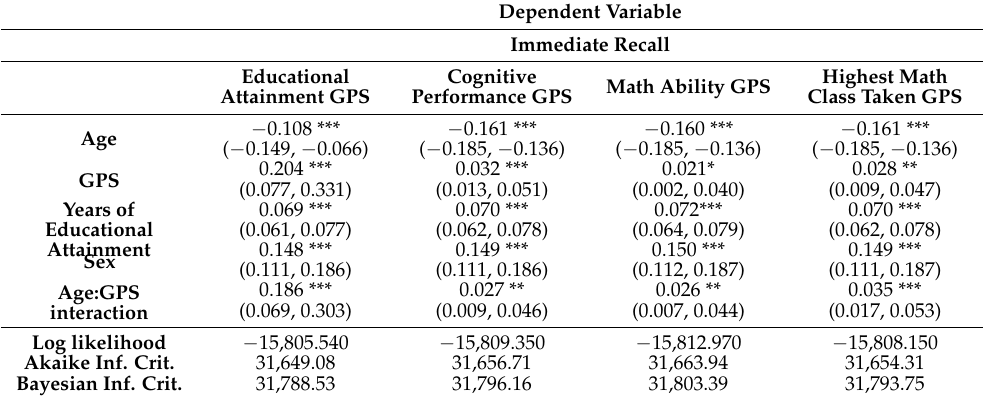
Table 2. Linear mixed-effects model analysis results for the temporal changes of the immediate recall assessment score of the WLS participants according to the cognitive capacity GPSs, including Educational attainment (EA), Cognitive Performance (CP), Math Ability (MA), and Highest Math Class (HM) with the age interaction effect. The effect size of each variable is presented with the 95% confidence interval in